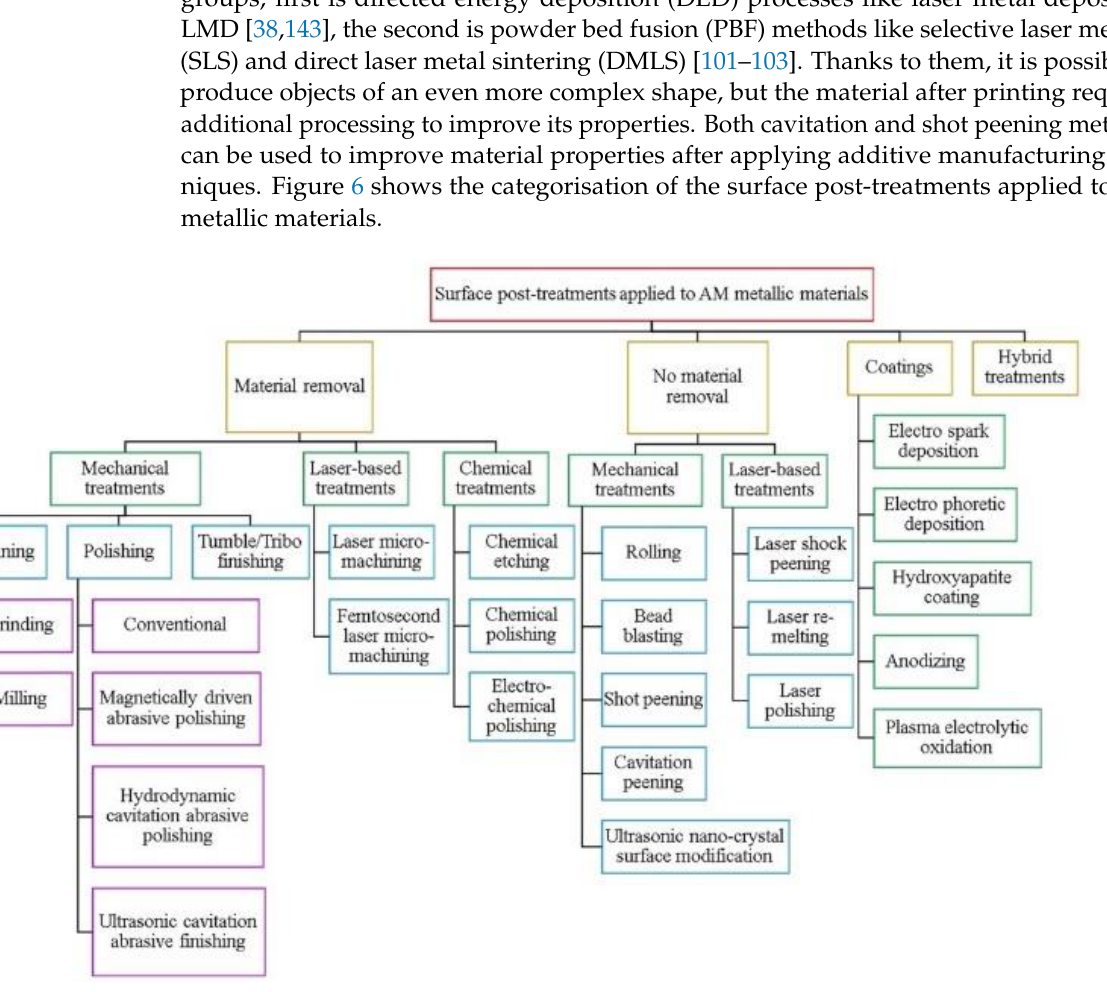
Figure 6. Categorisation of the surface post-treatments applied to AM metallic materials (reproduced with permission from Ref. [144], Copyright 2021,